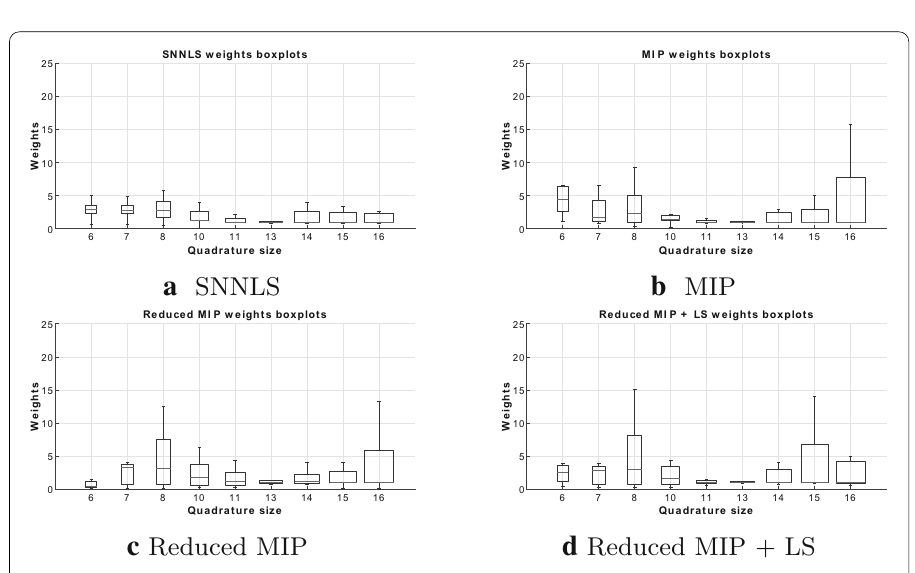
Fig. 16 Hyper-reduction weights boxplots for constraints reduction formulations in comparison with the SNNLS and MIP methods